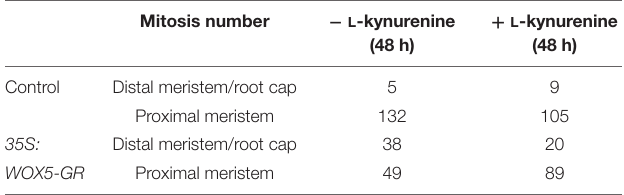
TABLE 1 | Quantitative analysis of mitosis distribution in the 35S:WOX5-GR root tips before and after 48 h of DEX incubation, with and without auxin synthesis inhibitor L